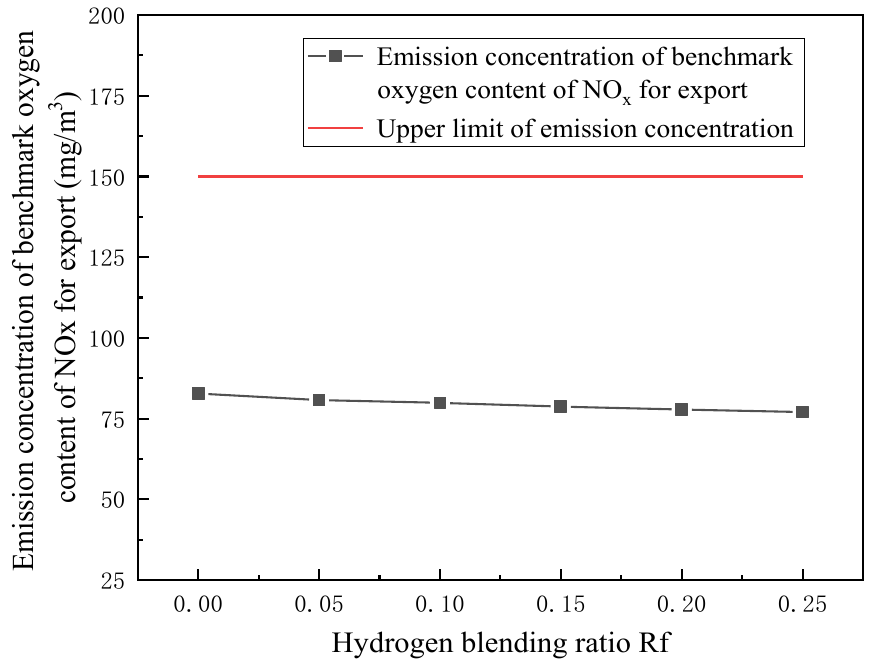
Figure 15. Emission concentration and limit standard of oxygen content of NO x for export.